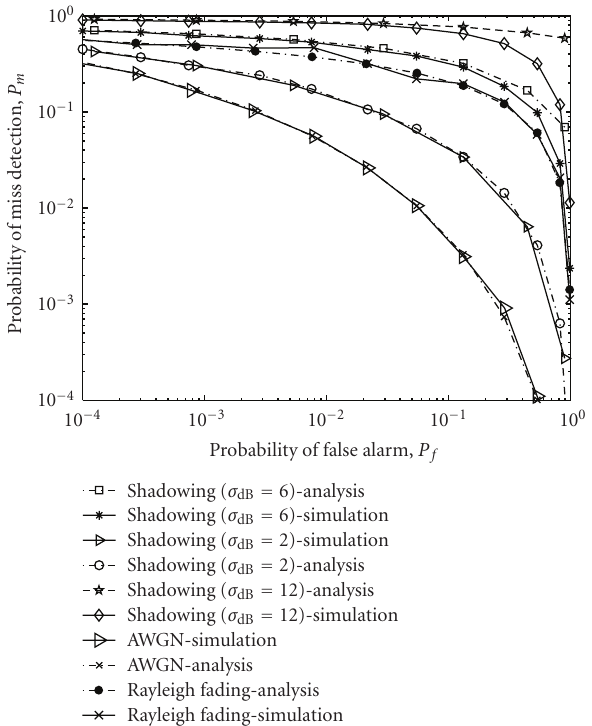
Figure 2: Receiver operating characteristics for local spectrum sensing in Rayleigh and Shadow Fading channels with γ = 5dB, N = 5.